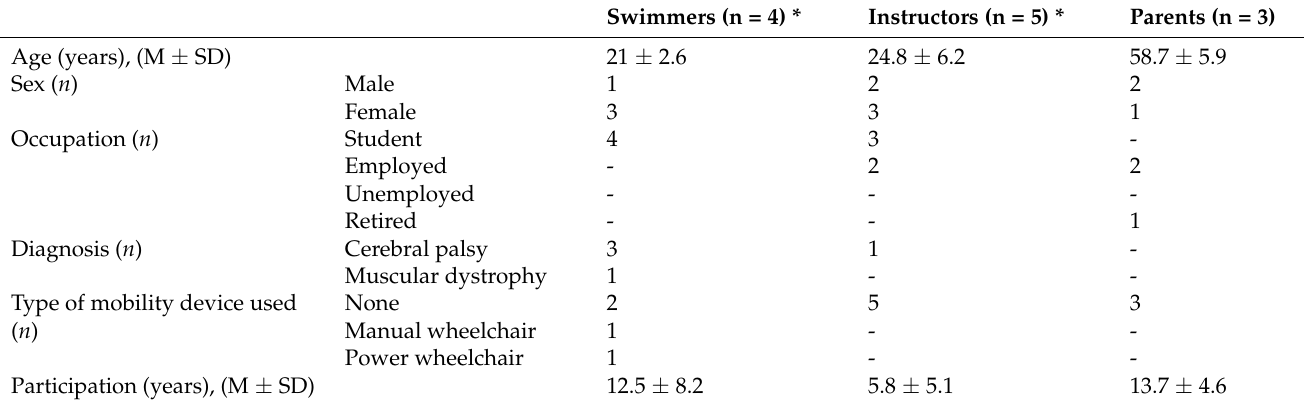
Table 1. Descriptions of the